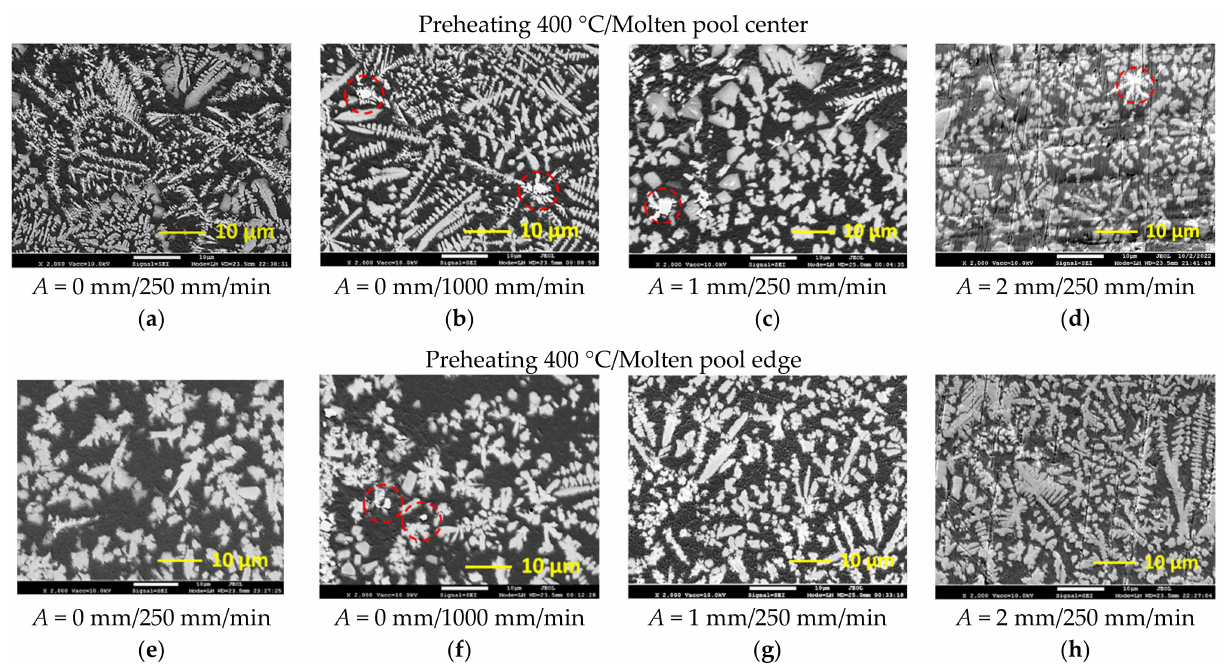
Figure 8. Microstructure of the central ( a – d ) and edge parts ( e – h ) of the molten pools obtained by laser remelting without preheating: ( a , b , e , f )—without oscillation; ( c , g )—with 1 mm oscillation amplitude; ( d , h )—with 2 mm oscillation amplitude; the non-melted WC particles are marked with red circles.